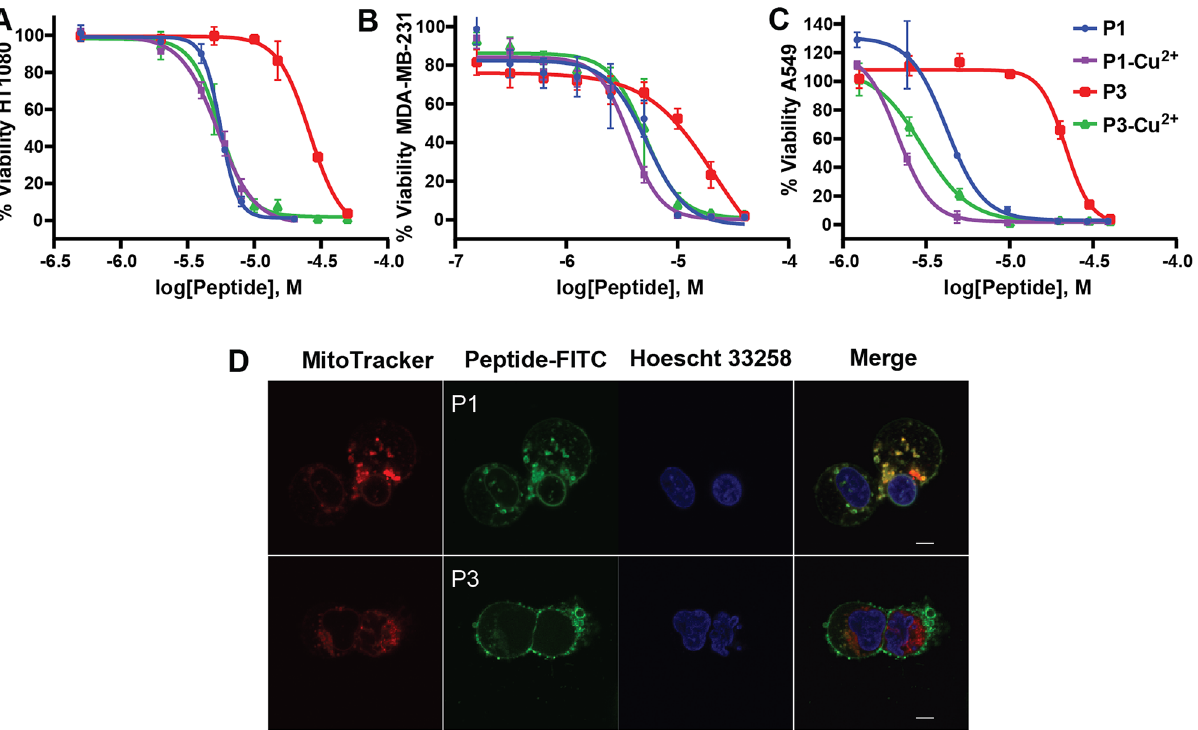
Figure 1. Cytotoxicity assays for the apo- and holo-states of P1 and P3 acting on cancer cells. Fibrosarcoma (HT1080), breast (MDA-MB-231), and lung (A549) cancer cell lines (panels A, B, and C, respectively) were used to measure cell viability after 24 h of treatment with different concentrations (M = mol/L) of P1 and P3 in the apo- and Cu 2+ -bound states. Error bars are standard deviations based on triplicates. The IC 50 values are summarized in Table 1. Similar results were obtained after 48 h (Fig. S1). The peptides were metallated using a 1:1 stoichiometric amount of CuCl